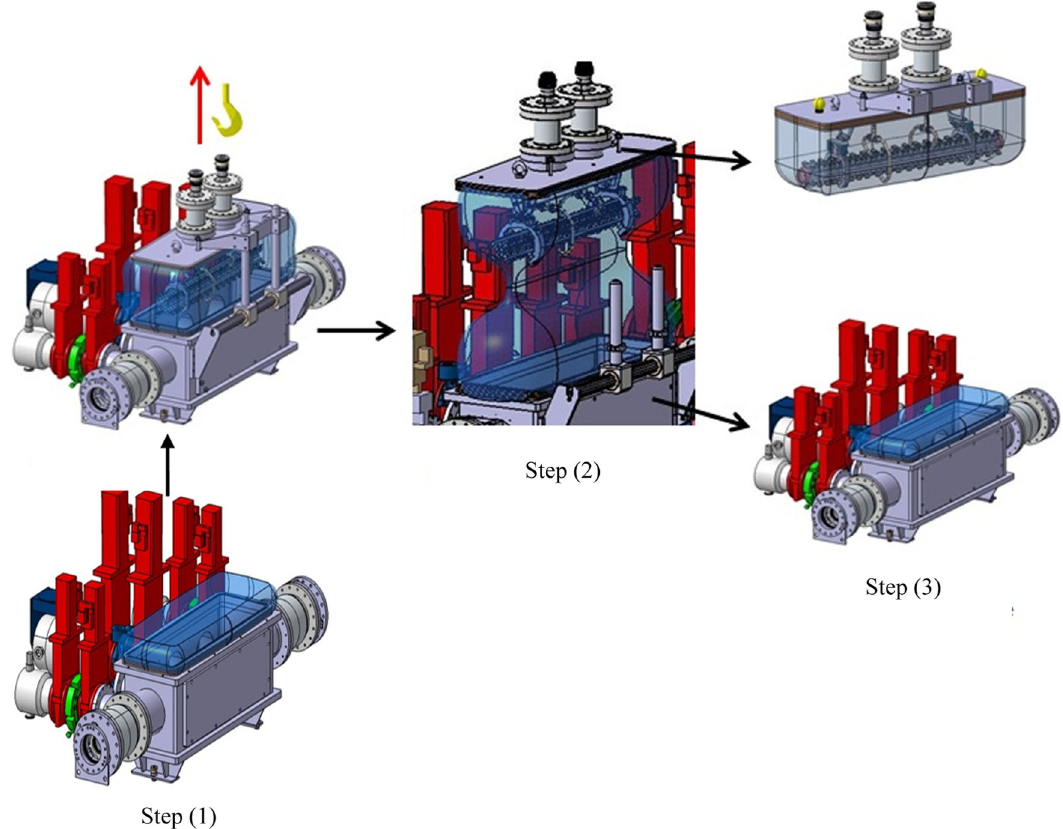
FIG. 13. Safety maintenance of the RFQ module: Establishment of confinement vinyl and withdraw of the module (Step 1), creation of two volumes (Step 2) and separation of two subsets (Step